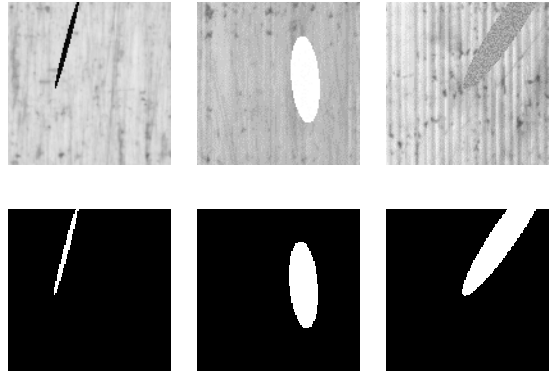
Figure3. ( top )Simulateddefectsonotherwisedefect-freeimages. ( bottom )Correspondingsegmentation Figure 3. ( top ) Simulated defects on otherwise defect ‐ free images. ( bottom ) Corresponding images used as labels during neural network segmentation images used as labels during neural network training.